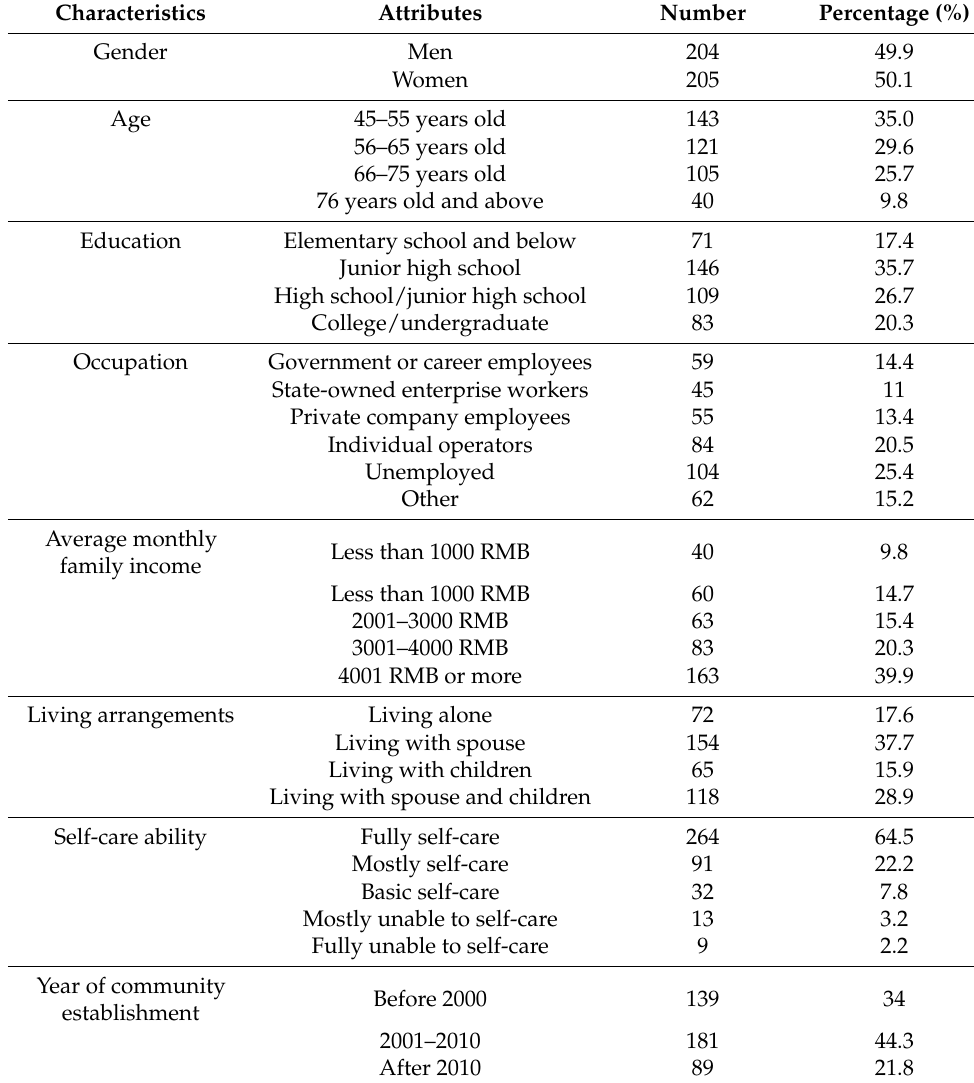
Table 2. Description of socio-demographic